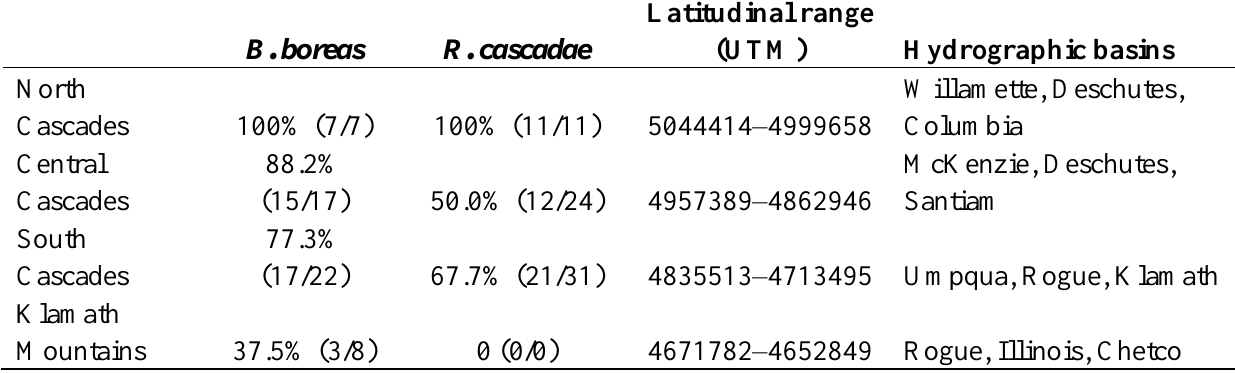
Table 4. Percentages of historical breeding sites where B. boreas or R. cascadae were found breeding > 1 year, from 2001 to 2004 (Oregon, USA). Latitudinal range and main river basins are also shown for sample sites in each region (per Figures 1 and